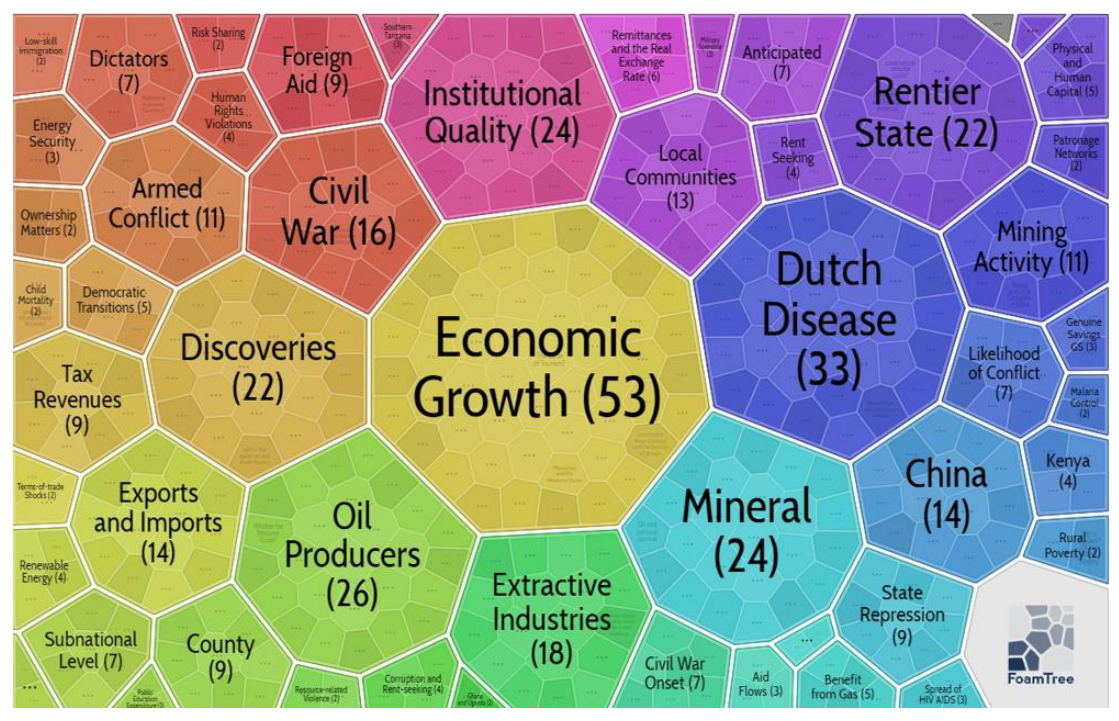
Figure 24. Keywords in Cluster 2 (using Carrot2 4.3.1).